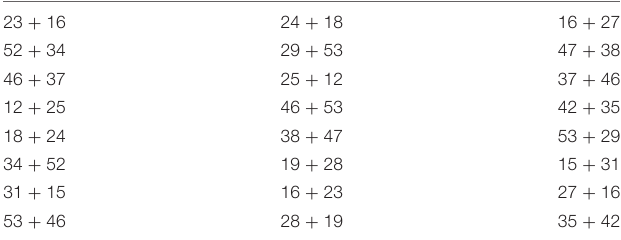
TABLE 2 | Double-digit addition